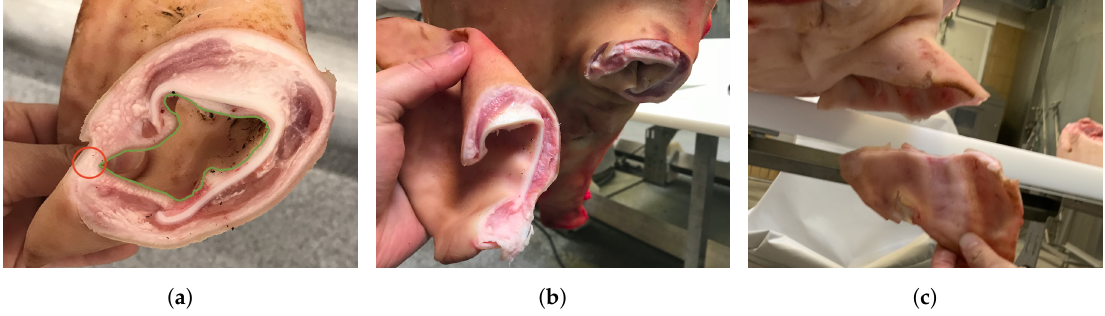
Figure 2. ( a ) Borderline, too close to the head. ( b ) Good. ( c ) Bad, too far from the